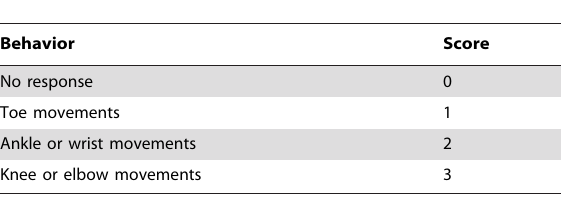
Table 1. The behavioral response